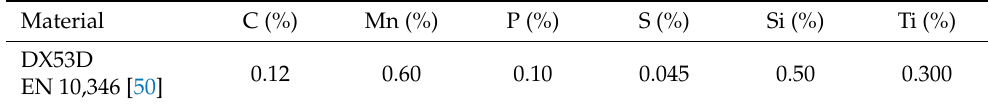
Table 4. The chemical content of the applied steel raw material (the percentages are mass %).